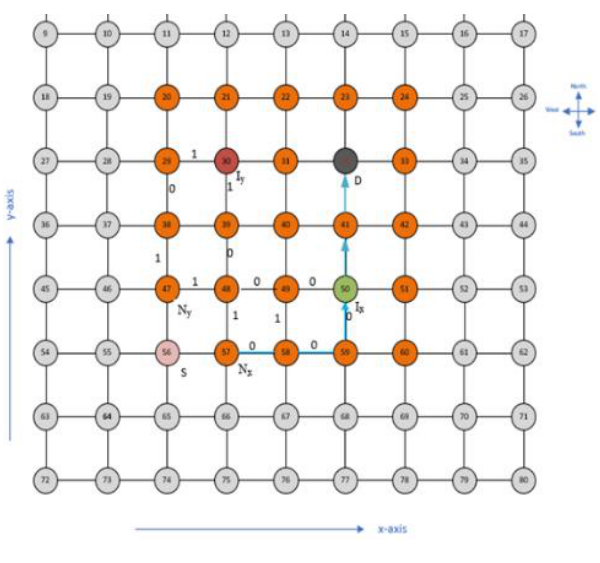
Fig. 8. 2D mesh Network having source and a destination node in HCA to implement Algorithm 1